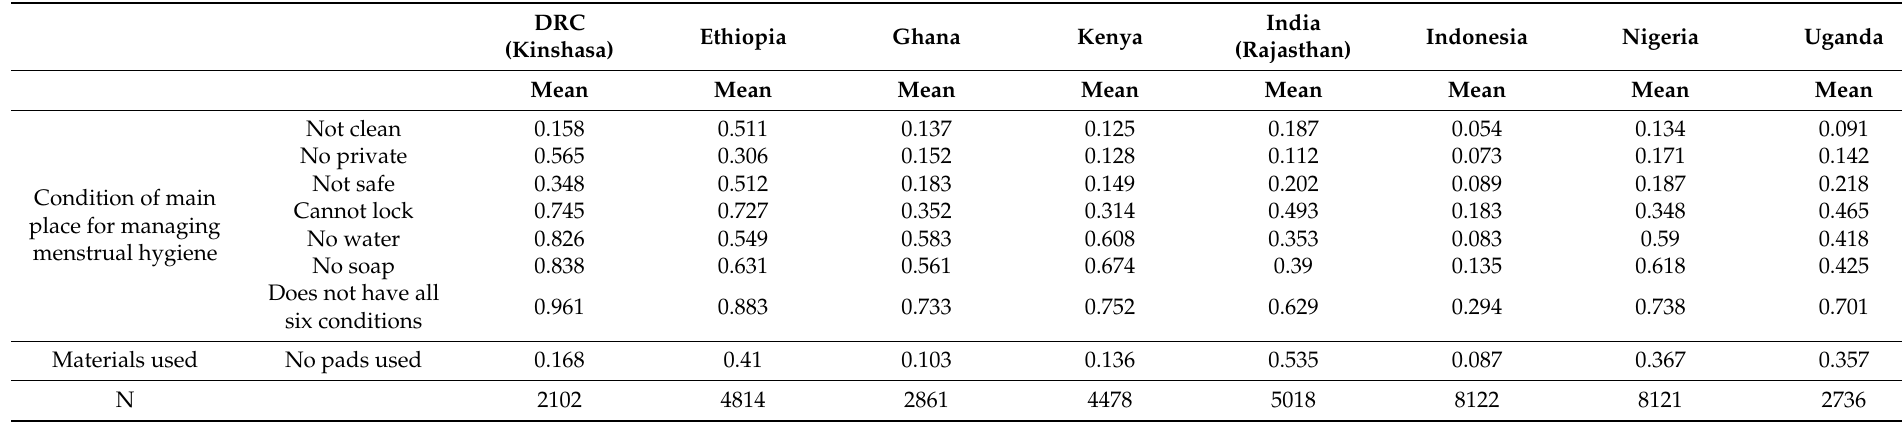
Table 2. Summary statistics.